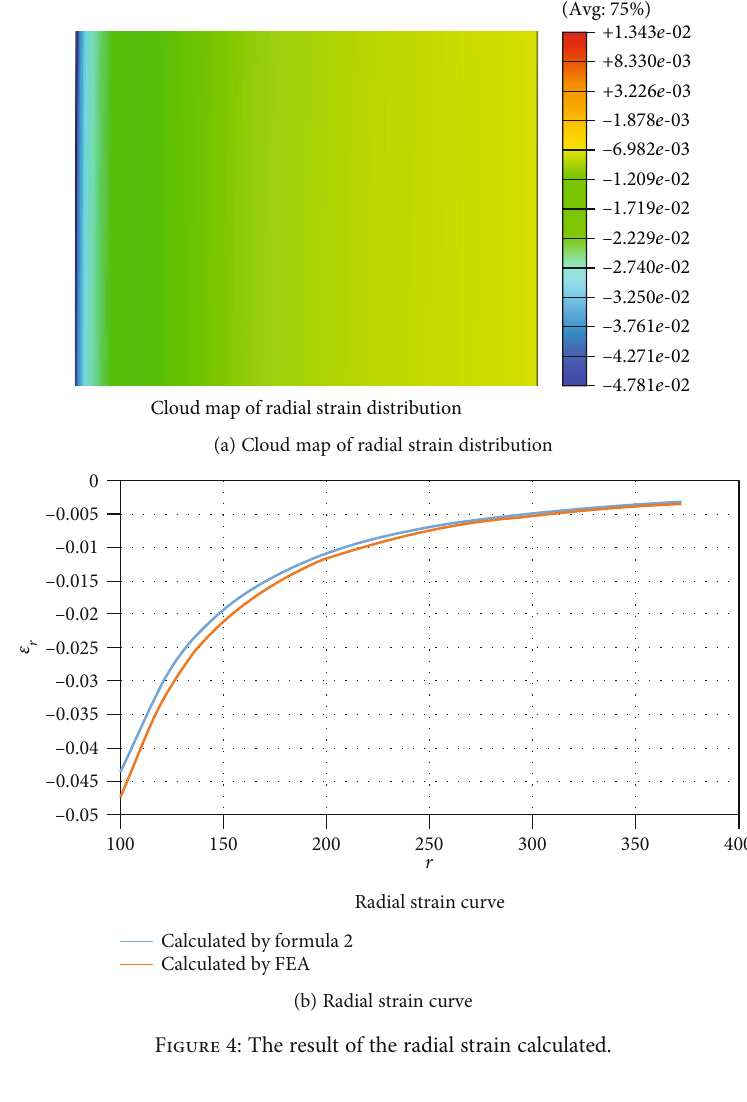
Figure 4: The result of the radial strain calculated.